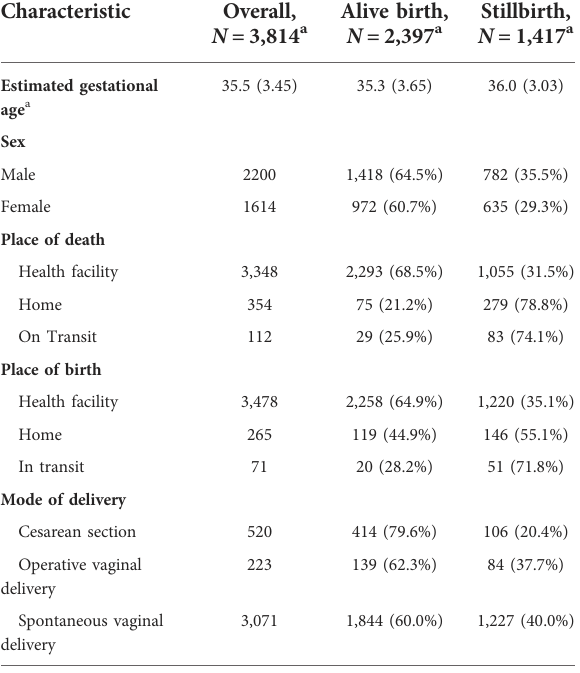
TABLE 5 Assigned cause of death by the outcome of the perinate in Ethiopia,